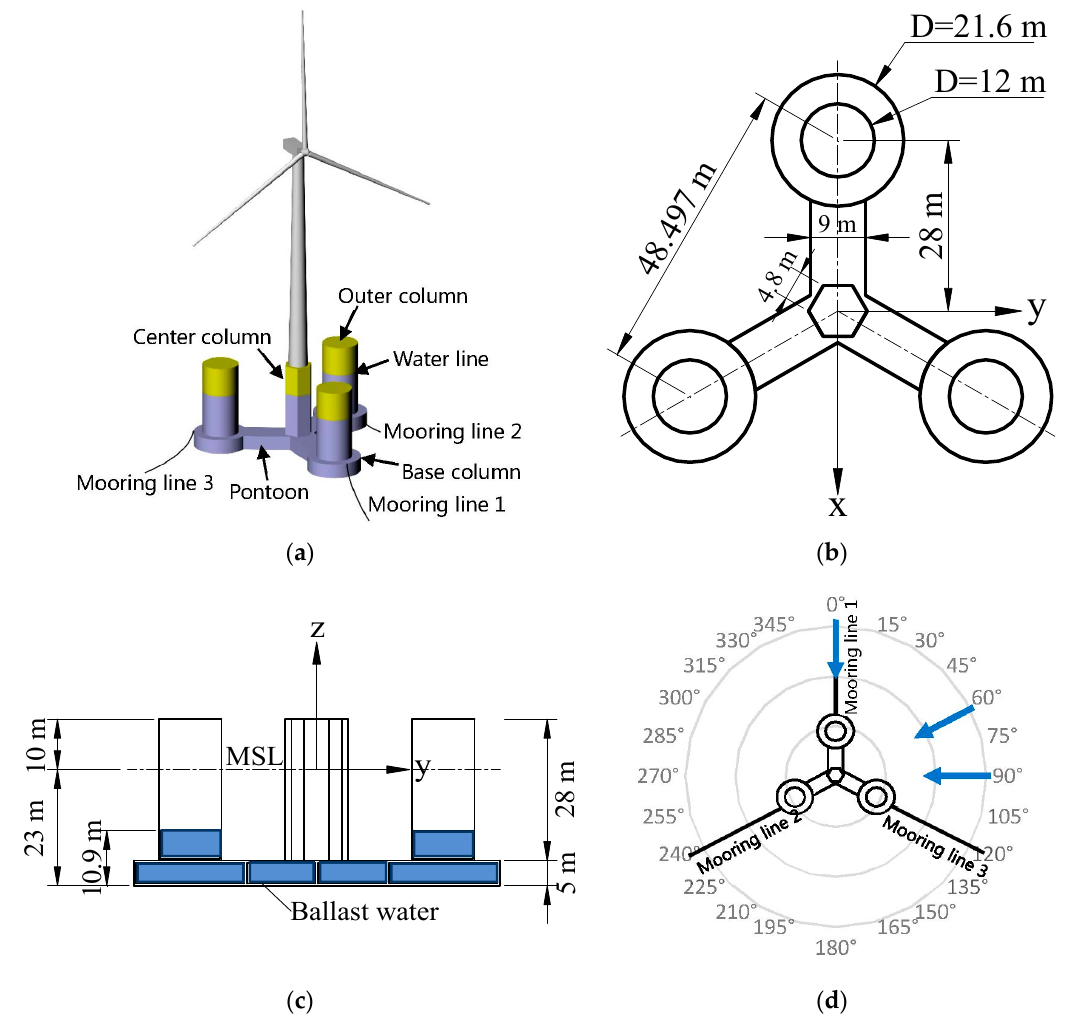
Figure 1. The ConFloat semi-submersible platform: ( a ) 3D model; ( b ) Dimensions of the platform; ( c ) Side view of the platform; ( d ) Definition of wind/wave load directions.